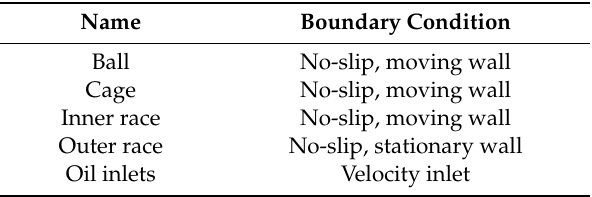
Table 2. Boundary